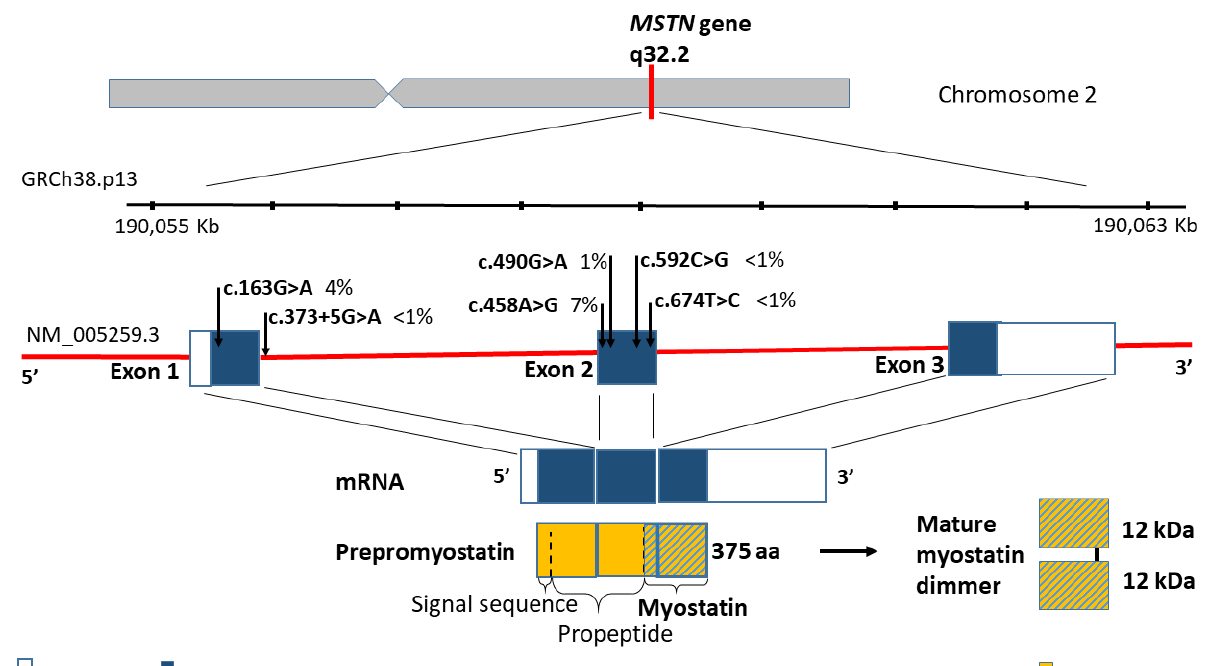
Figure 2. MSTN gene structure, variants distribution and the protein product.